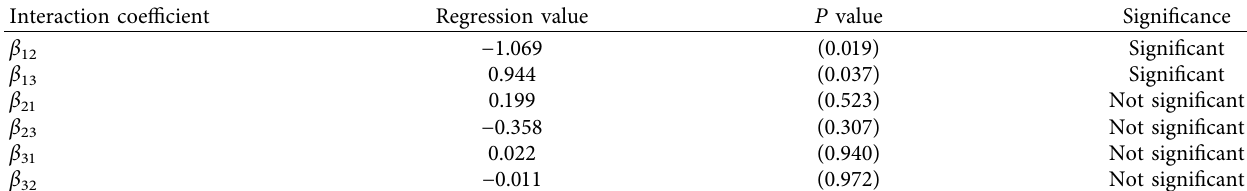
Table 6: Regression results of interaction